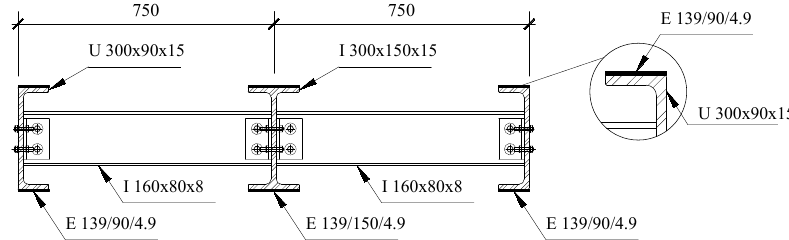
Figure 2. Cross-section of the FRP footbridge (all dimensions in millimetres). GFRP I 160 × 80 × 8 elements spaced 1.25 m from the pinned and roller supports and every 1.20 m along the rest of the bridge length act as lateral restraints. Plank HD panels, coated with anti-skid surface, comprise the bridge deck, and their pultrusion direction is aligned transversally to the traffic direction. Stainless steel cables